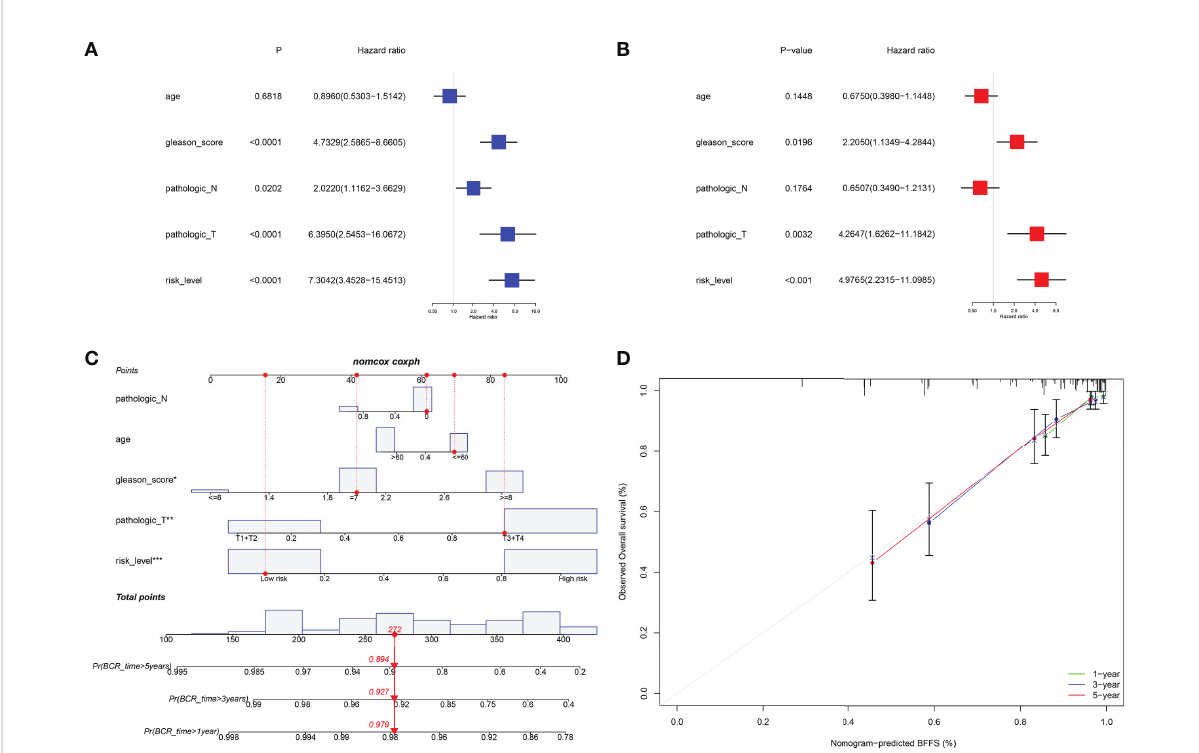
FIGURE 4 Internal validation of risk signature in TCGA. (A, B) Univariate and multivariate Cox regression analysis in TCGA cohort. (C) Nomogram based on this signature for 1, 3, 5-year BFFS prediction (The red point represented the prediction of one patient in TCGA cohort). (D) Calibration graph for agreement test between 1, 3, 5-year BFFS prediction and actual observation.